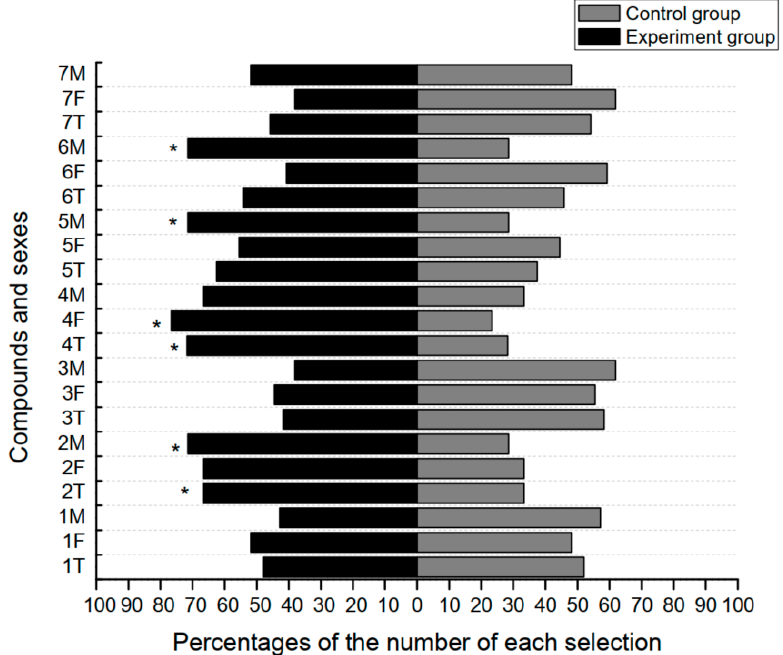
Figure 4. Sclomina erinacea individuals’ preference to seven kinds of VOCs produced by Hypolepis punctata . Different numbers on the Y-axis represent seven different chemicals: 1 = α -pinene; 2 = trans-2-hexenal; 3 = hexanal; 4 = linalool; 5 = β -myrcene; 6 = nonanal; 7 = 1-octen-3-ol; M = males; F = females; T = total. The proportion of the selection between the control group (hexane group) and the experimental group (different tested chemicals) in each condition on the Y-axis is represented using two different colors. A G-test was used to compare the selection of different groups, and * indicates that there is a significant difference between the choices of the control group and the experimental group. Table 4. Sclomina erinacea individuals’ preference in Y-olfactometer experiment to seven kinds of VOCs produced by Hypolepis punctata versus hexane. Compounds